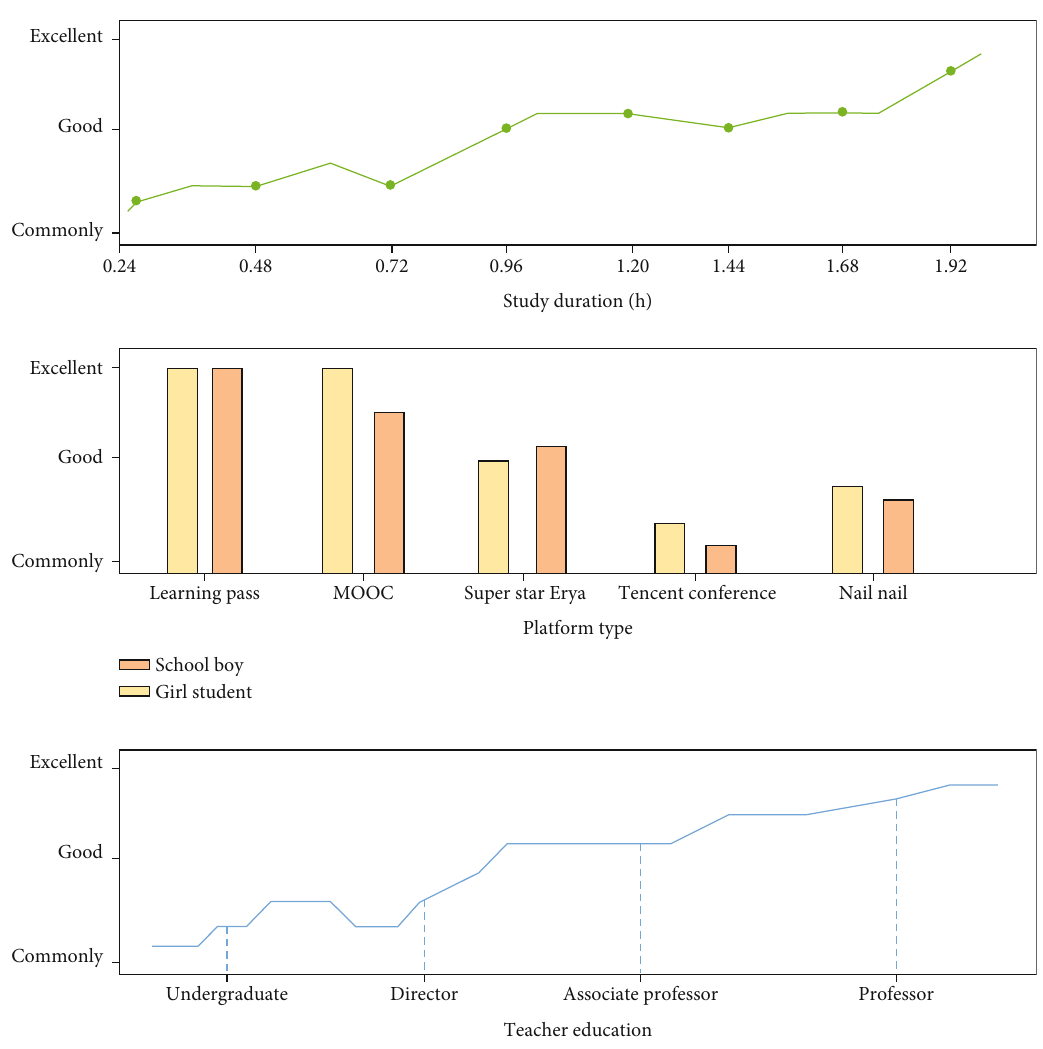
Figure 9: The impact of learning time, online teaching platform, and teachers ’ academic quali fi cations on students ’